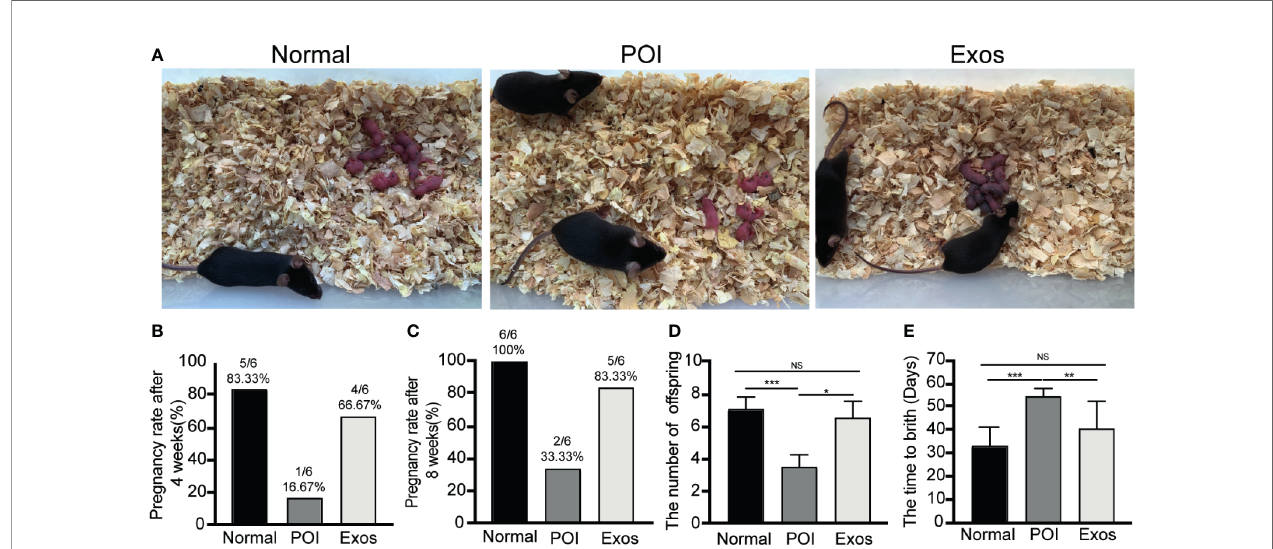
FIGURE 4 | Exosomes improved reproductive functions of POI mice. (A) Representative outcomes of reproduction in the three groups. (B) Pregnancy rate at 4 weeks after treatment. (C) Cumulative pregnancy rate at 8 weeks after treatment. (D) The number of offspring in the three groups. (E) Time to birth after treatment. Data are presented as percentage or mean ± SD; n = 6 per group; * p < 0.05, ** p < 0.01, *** p < 0.001; ns, no signi fi